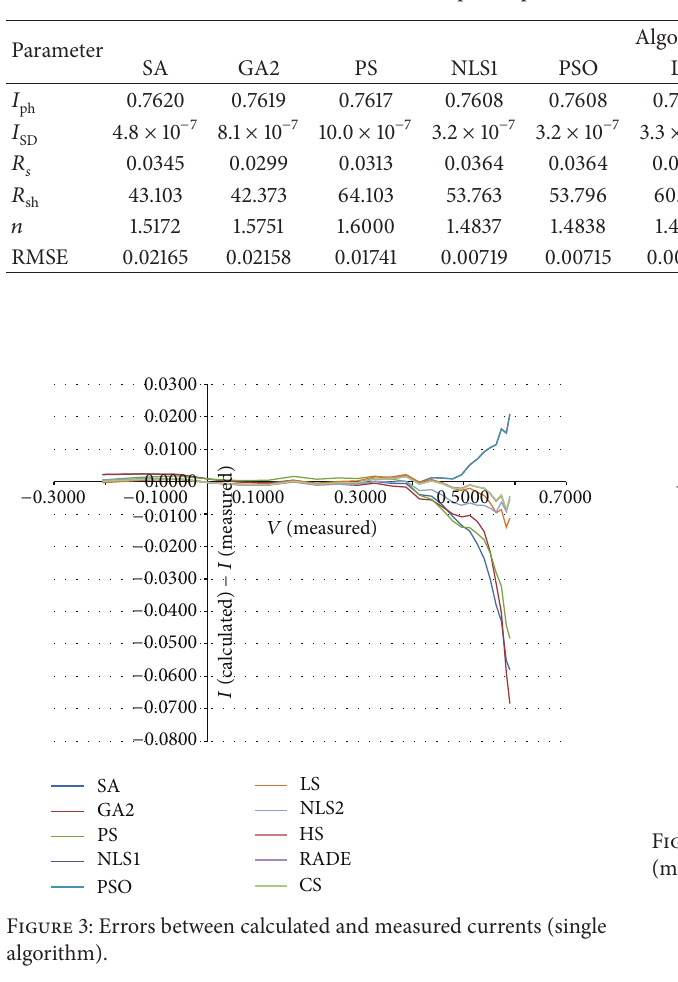
Table 2: Optimal parameter values from various algorithms.